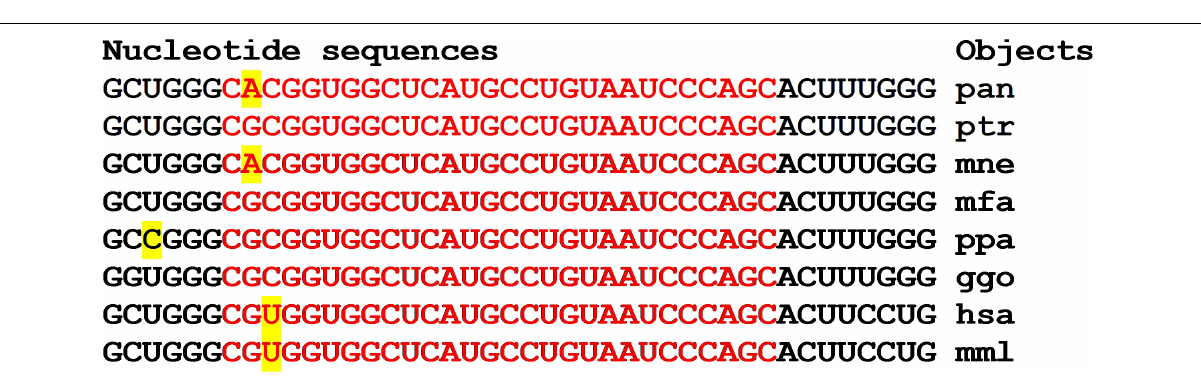
FIGURE 14 | Nucleotide sequences of 3 (cid:48) UTR regions of mRNAs of orthologous PRKN genes containing clusters of binding sites miR-5095 and